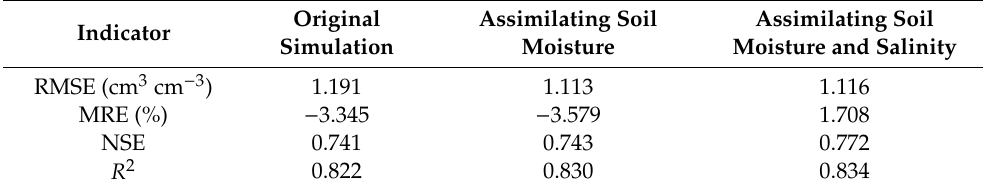
Table 4. Goodness-of-fit test indicators for simulations with the assimilation of soil salinity data. Indicator